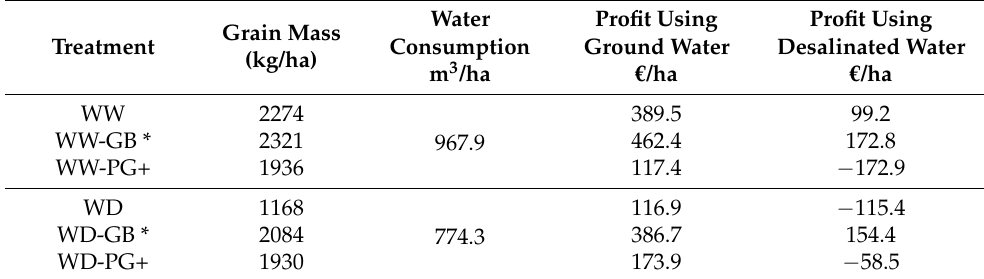
Table 5. Economic study of the selected biostimulant